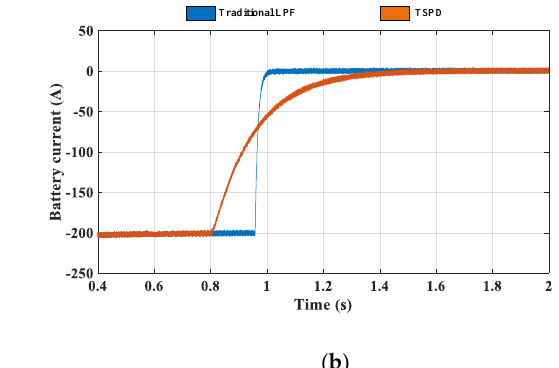
Figure 14. Sudden load and unload test waveform: ( a ) Current waveform; ( b ) Sudden load bus voltage waveform; ( c ) Sudden unload bus voltage waveform. It can be seen that when the load is suddenly applied, the super capacitor takes on the high-frequency power in the HESS through rapid discharge to slow down the drop of the DC bus voltage, while the change of the battery discharge current is relatively slow. When the load is suddenly unloaded, the super capacitor takes on the high-frequency power in the HESS through rapid charging to slow the rise of the DC bus voltage, while